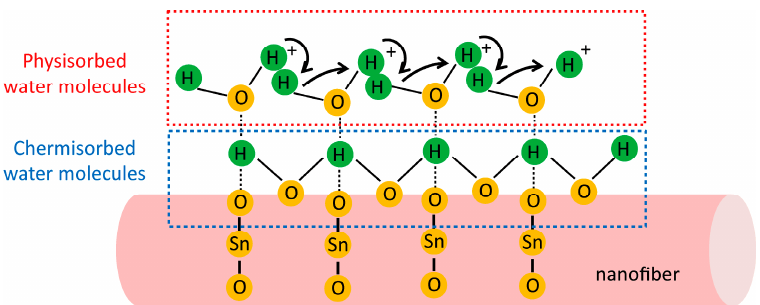
Figure 4. Schematic representation or the benefit of the one-dimensional characteristic structure of SnO 2 porous nanofibers on humidity sensing performance.